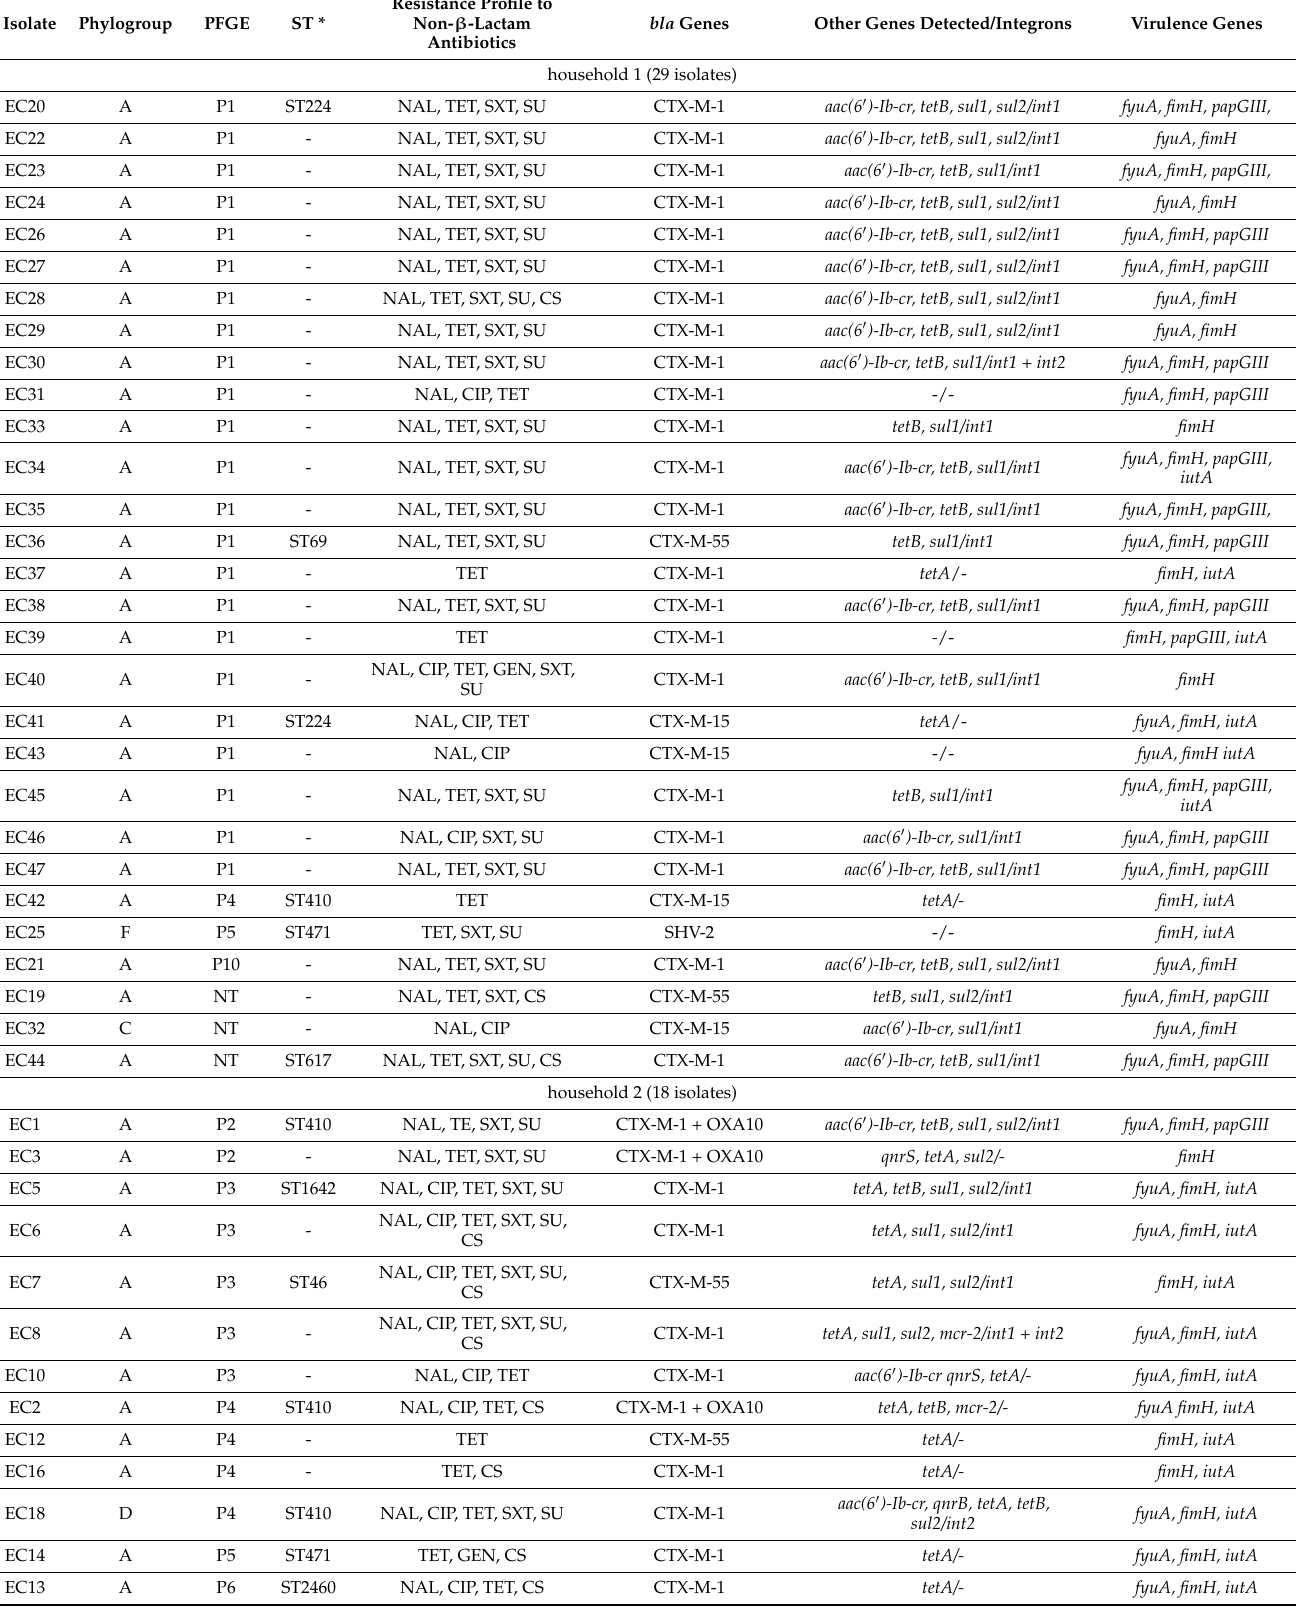
Table 1. Phenotypic and genotypic characteristics of the 47 ESBL-producing E. coli isolates collected from free-range